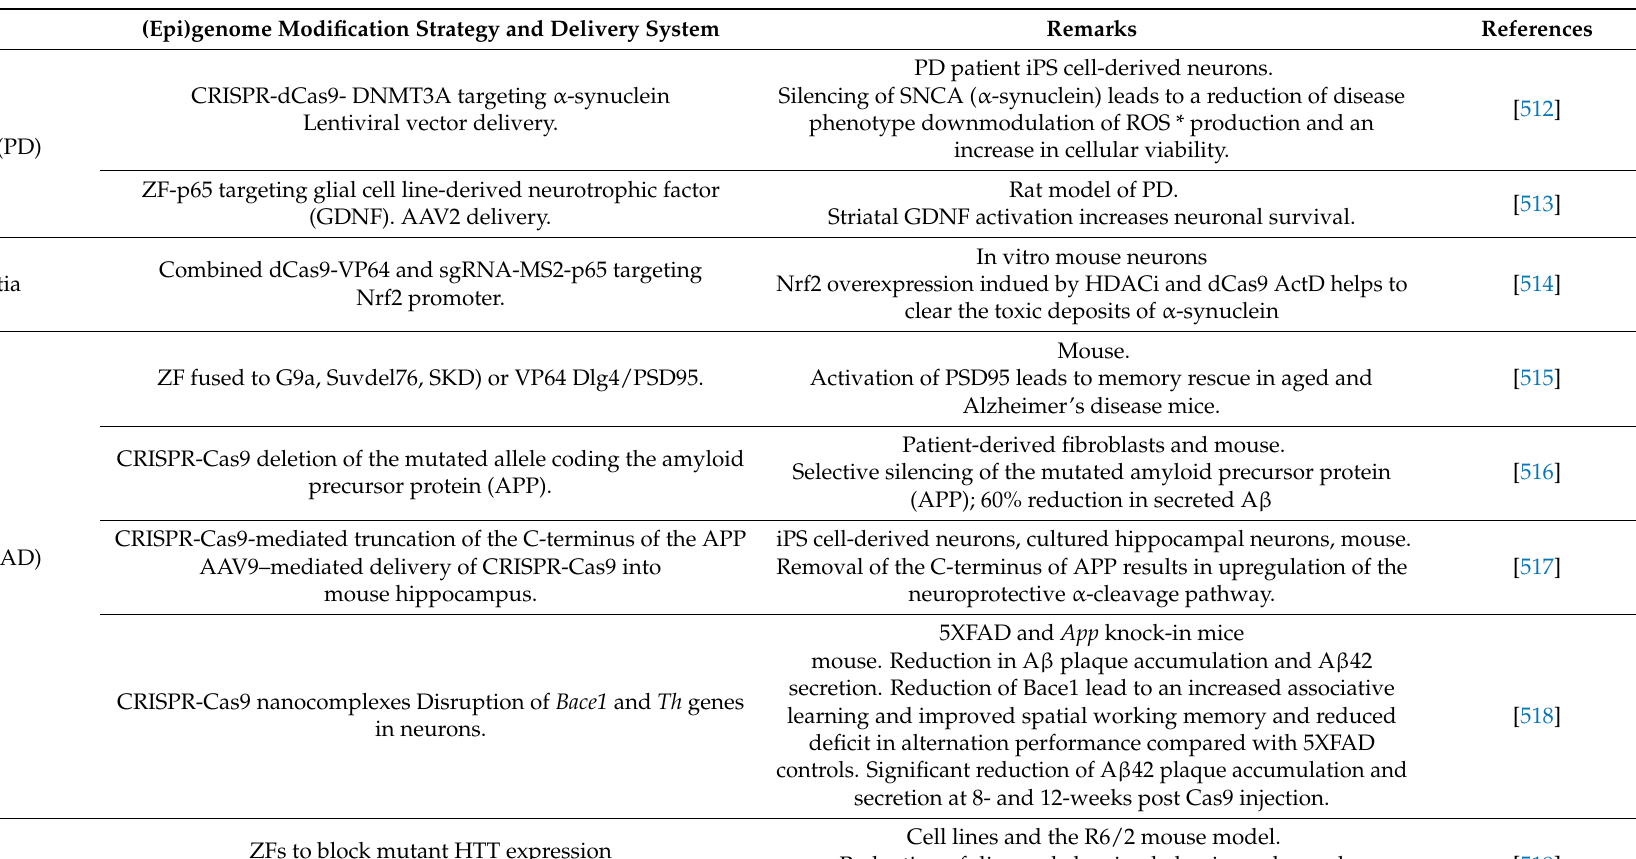
Table 3. (Epi)genome-targeting for treatment of